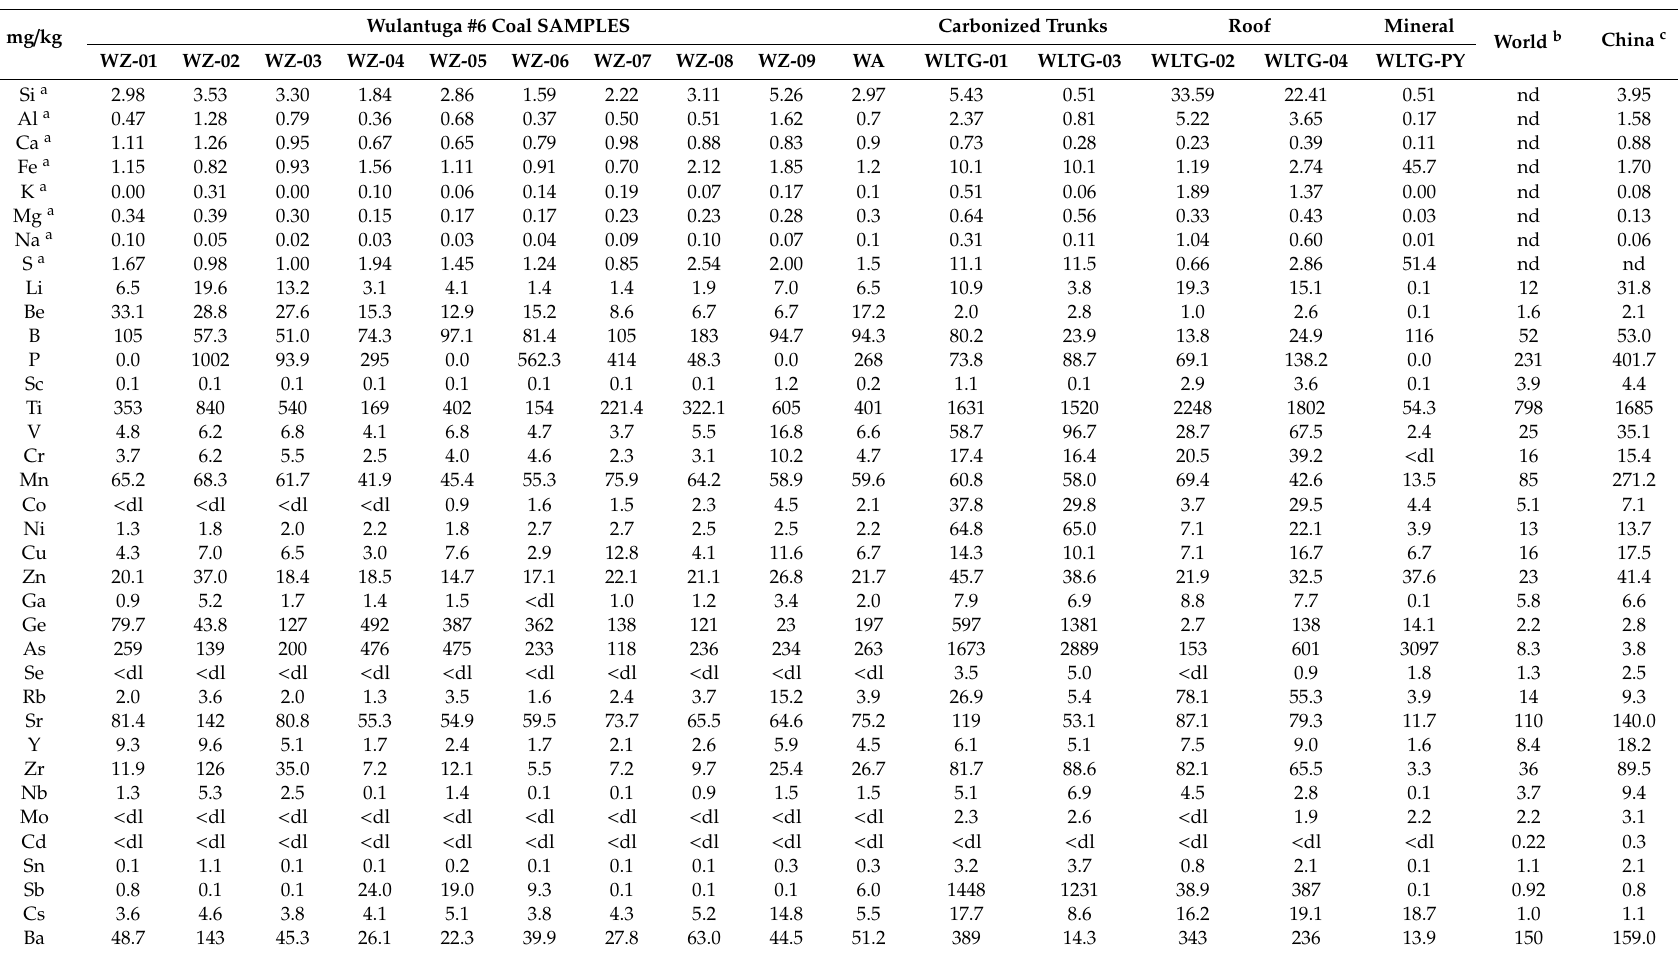
Table 4. Major and trace element contents in the Wulantuga coals, roof samples and coalified trunks (mg / kg db) and comparison with the worldwide and Chinese usual concentration ranges in